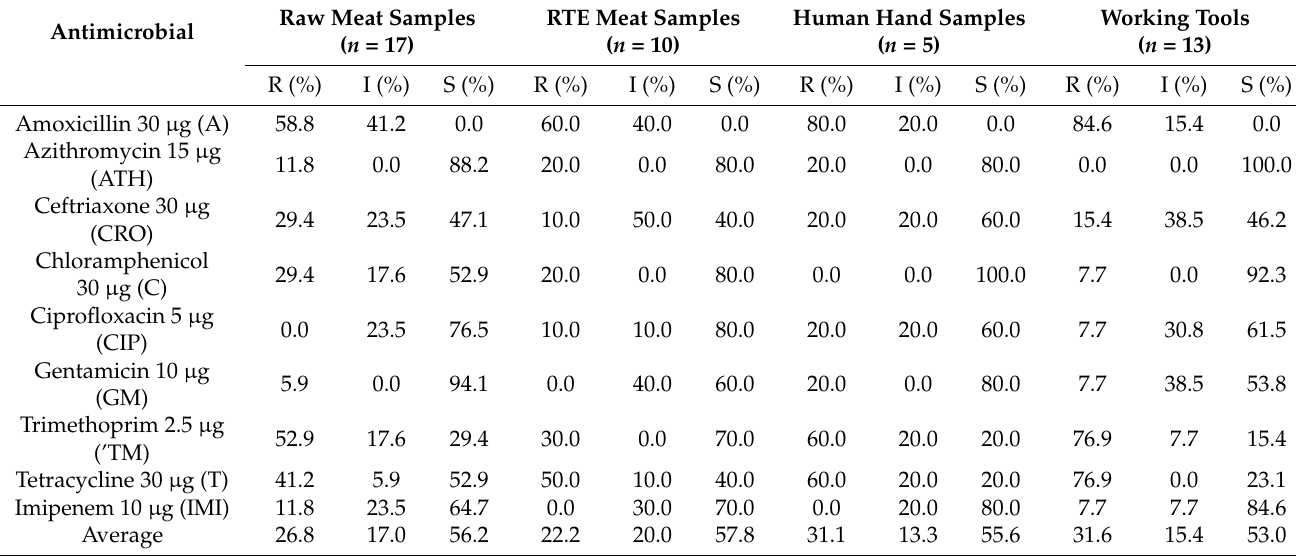
Table 2. Phenotypic antibiotic resistance of E. coli ( n = 45) isolated raw meats, RTE meats, hands and working tools of meat sellers.